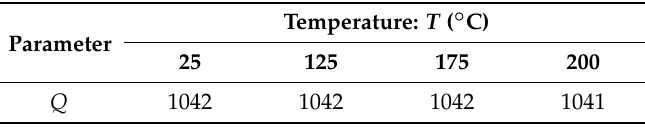
Table 6. Q values for the digital lock-in amplifier at different temperatures.